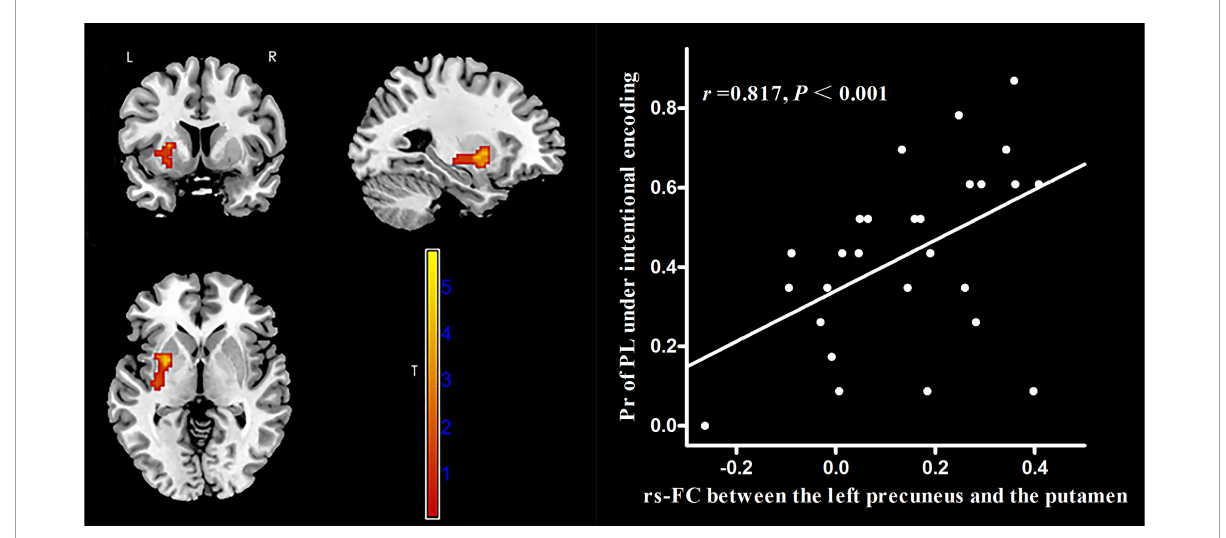
FIGURE6 Correlation between voxel-wise rs-FC of the left precuneus and the left putamen and the Pr-PL (positive stimulus with low arousal) under intentional encoding in MWoA patients. p < 0.05, cluster-level FWE corrected. Scatter plot of ROI-based partial correlation analysis between rs-FC and the Pr-PL.